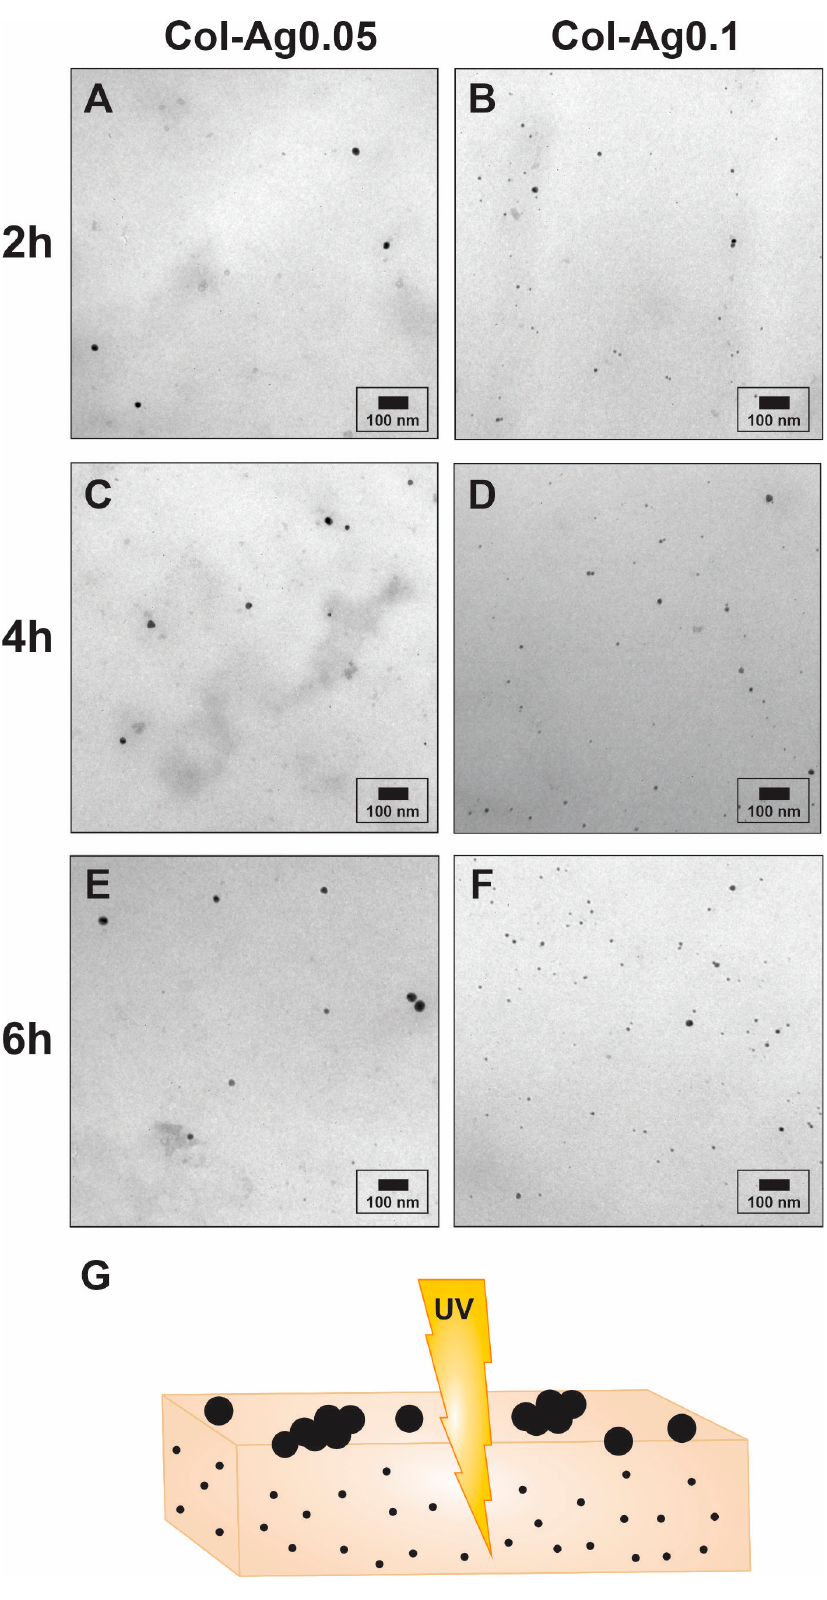
Figure 3. TEM images of the AgNPs formed inside the 3D-printed collagen-based scaffolds. A : Col-Ag0.05-2; B : Col-Ag0.05-4; C : Col-Ag0.05-6; D : Col-Ag0.1-2; E : Col-Ag0.1-4; F : Col-Ag0.1-6. G : schematic illustration of the variation of the size of the silver particles according to the place of the material where they are formed.